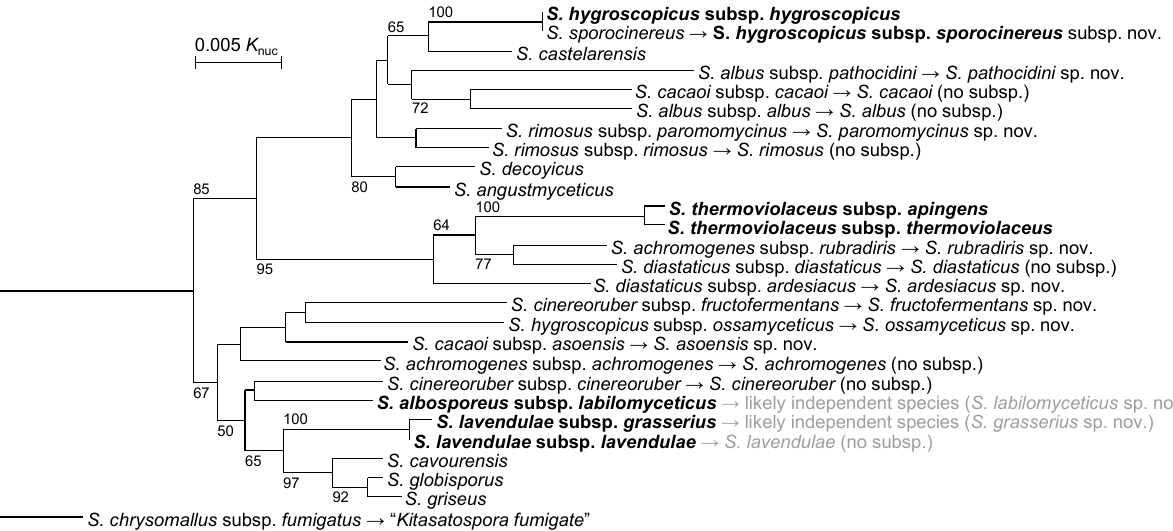
Figure 4. Phylogenetic tree of the members in Figure 3 with updated names based on 16S rRNA gene sequences. As members reclassified as synonyms and a new subspecies ( S. hygroscopicus subsp. sporocinereus ) were removed and added, respectively, this tree includes only the present type strains. The genus Streptomyces still includes seven subspecies at present, shown as boldfaced. Since S. albosporeus subsp. labilomyceticus and S. lavendulae subsp. grasserius are likely two novel independent species, Streptomyces labilomyceticus sp. nov. and Streptomyces grasserius sp. nov., respectively, as shown in gray [47], there are indeed only four subspecies in this genus. Type strains of S. albidoflavus , S. anulatus , S. aurantiacus , S. cyaneofuscatus , S. hiroshimensis , S. microflavus , S. nigrescens and S. platensis are not included in the same manner as Figure 3 to highlight the results by current reclassifications. The other footnotes, such as descriptions on the numbers on branches and the outgroup are the same as those in Figure 3.